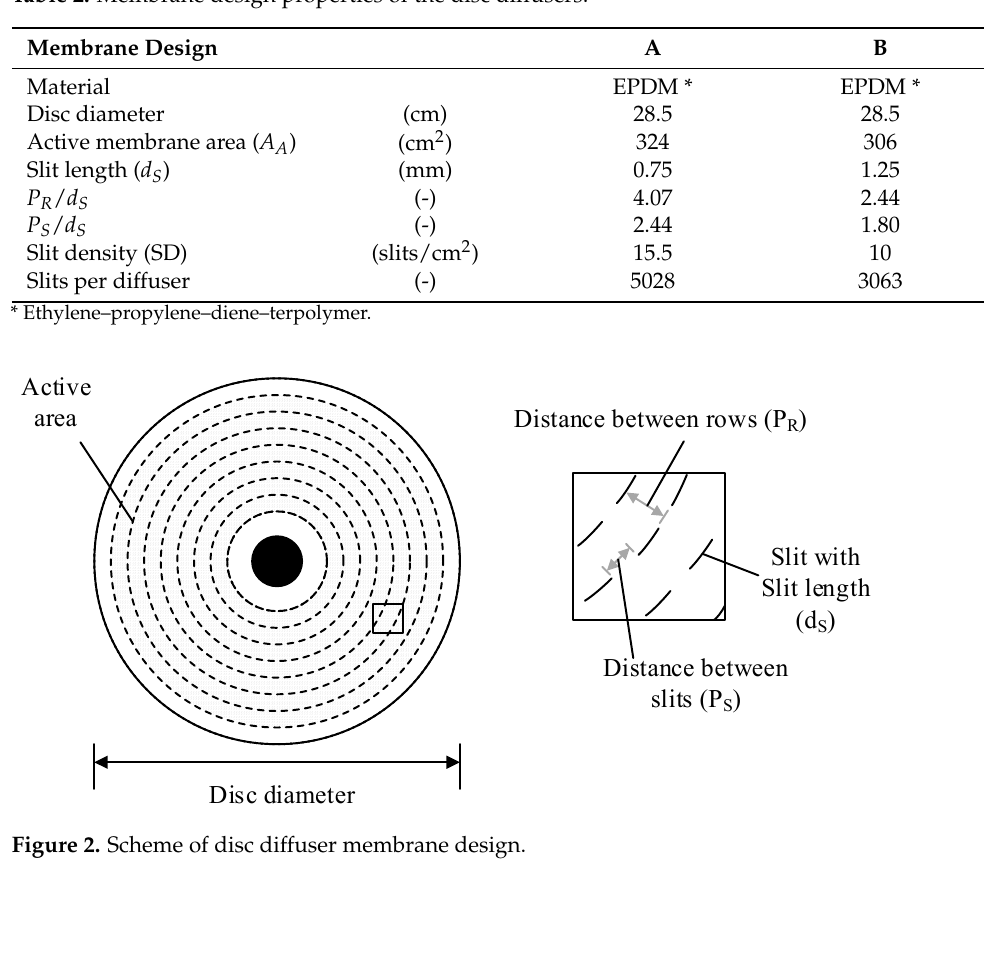
Table 2. Membrane design properties of the disc diffusers.